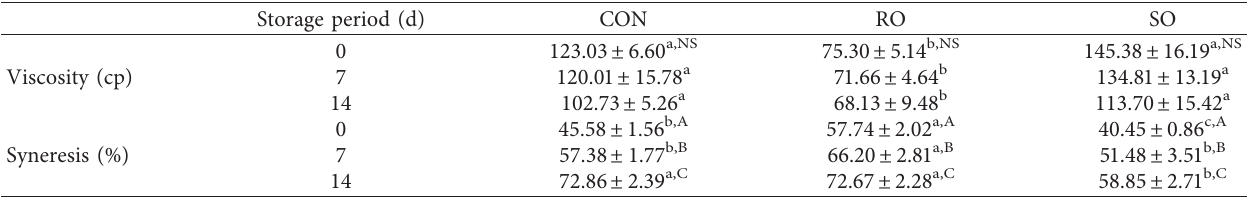
Table 2: Viscosity and syneresis during the storage of yogurts.